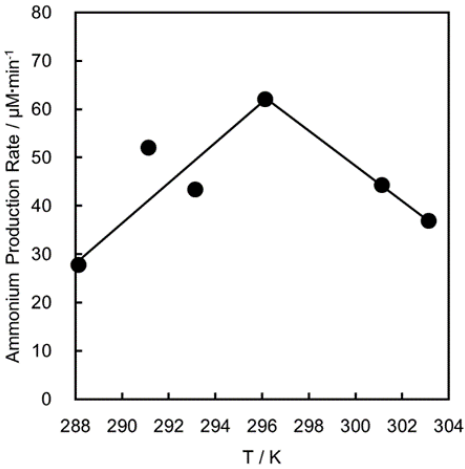
Figure 1. Temperature dependence of the nitrite-reducing activity of NiR derived from spinach.